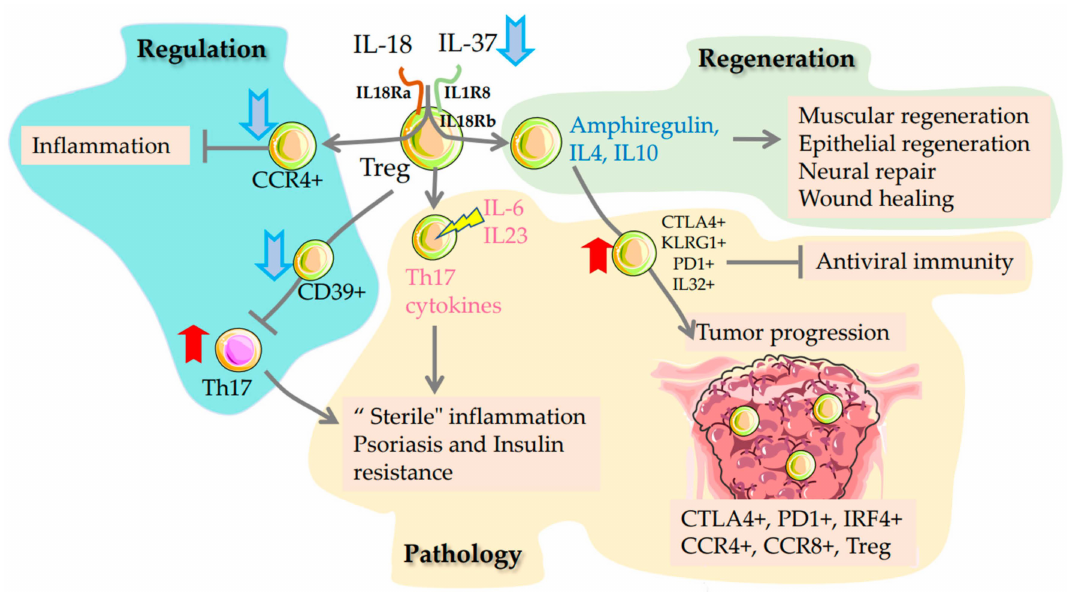
Figure 2. Ageing of T-regulatory cells. T regs ageing mechanisms change the functional properties of cells. The immunosuppressive (regulatory) function is reduced due to decreased maturation and differentiation of T regs populations (blue area). Shift in the balance between IL-18 and IL-37 alters the efficiency of T regs differentiation and their ability to support tissue regeneration (green area). The cytokines involved in regeneration are shown in